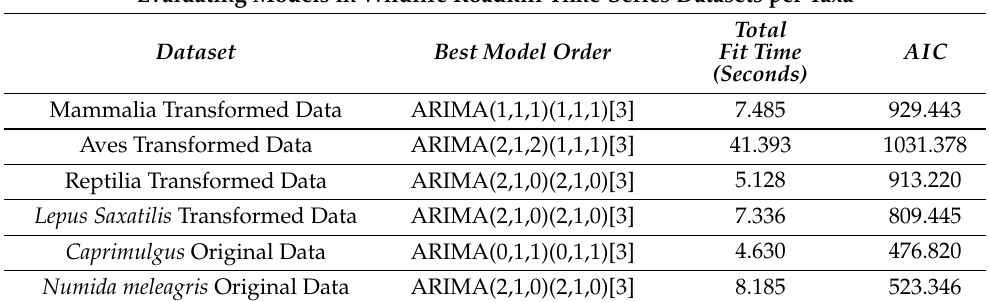
Table 6. Selecting models with the least AIC . Positive values mean much information is lost and neg- ative values mean less information is lost. The smaller the AIC value, the lesser the information lost, and the higher the AIC value, the bigger the information lost.